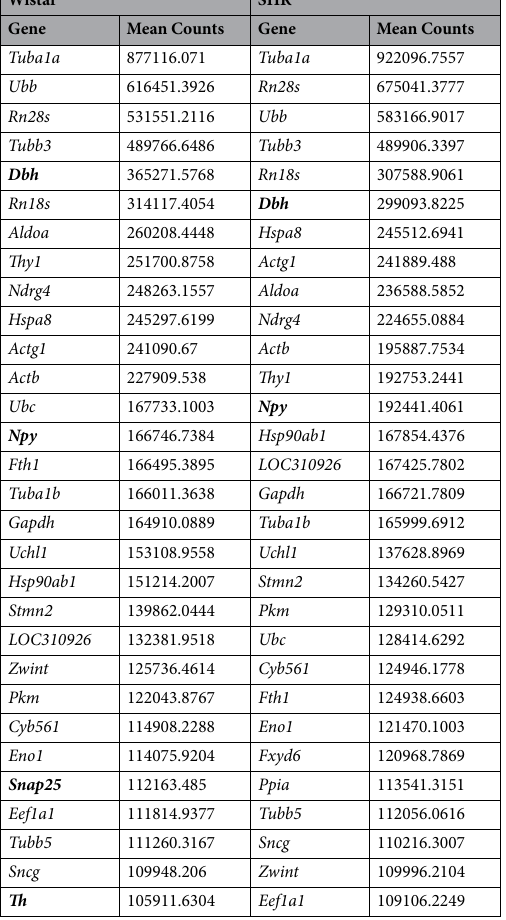
Table 2. Defining the transcriptome of Wistar and SHR stellate ganglia. The table includes a list of the top 30 genes and their respective mean counts in stellate ganglia obtained from Wistar and SHR. Genetic markers of sympathetic neurons are highlighted in bold. No significant difference was found for any of the sympathetic or neuronal markers in this